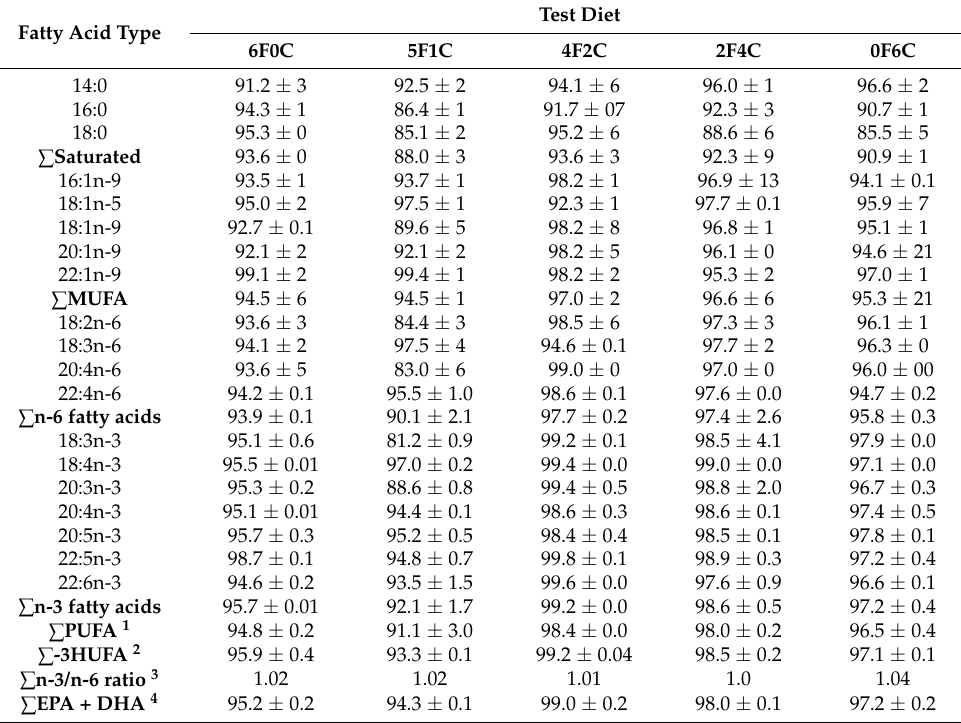
Table 7. Apparent digestibility (%) of fatty